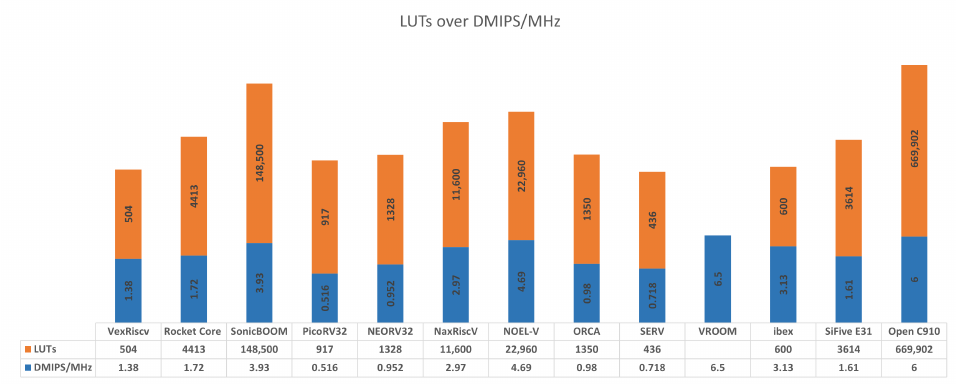
Figure 2. Hardware resource utilization and performance